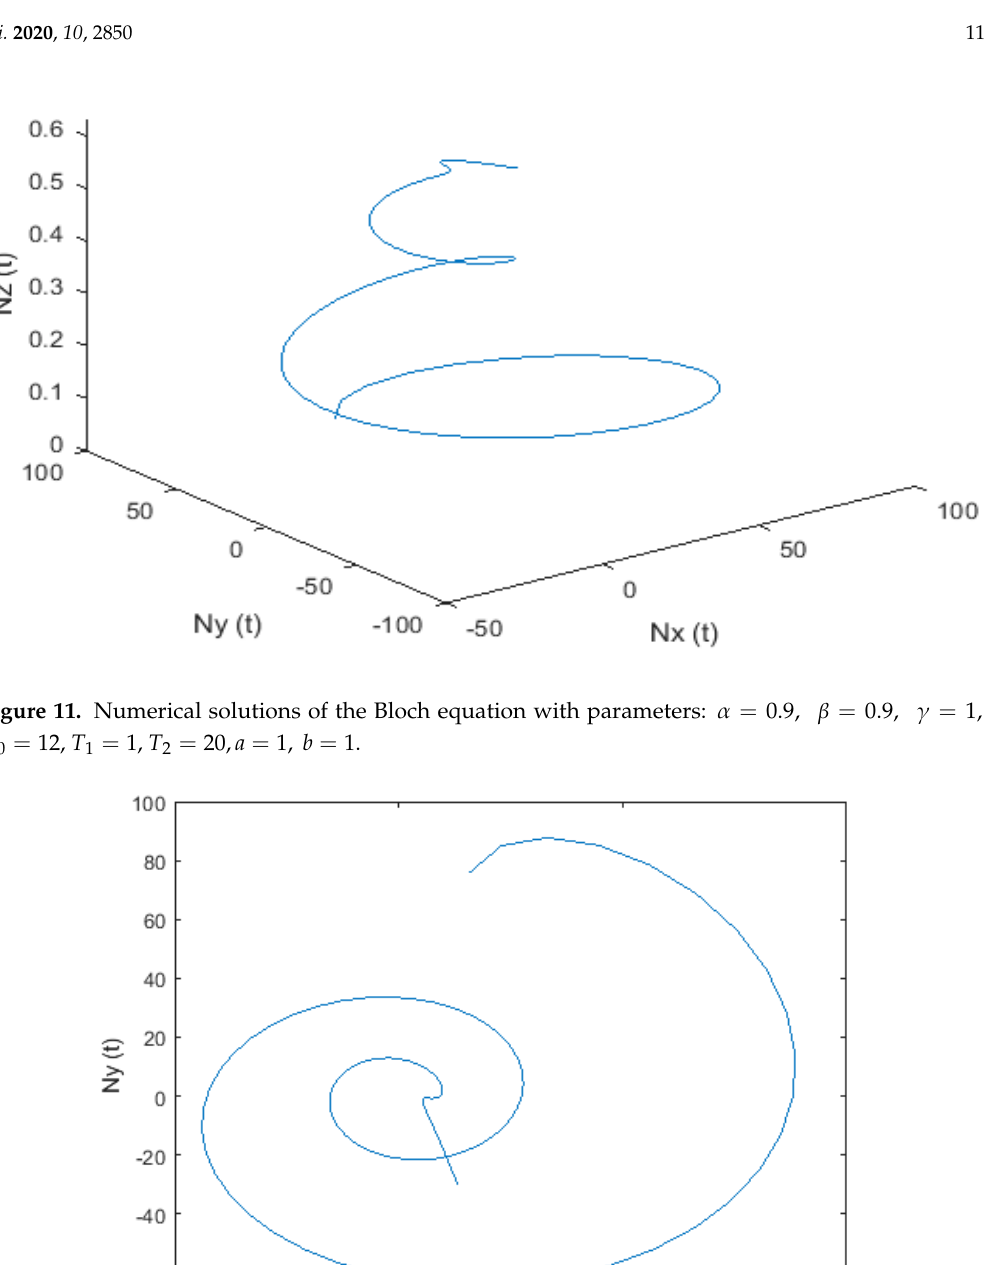
Figure 12. Numerical solutions of the Bloch equation in the plane α = 0.9, β = 0.9, γ = 1, w